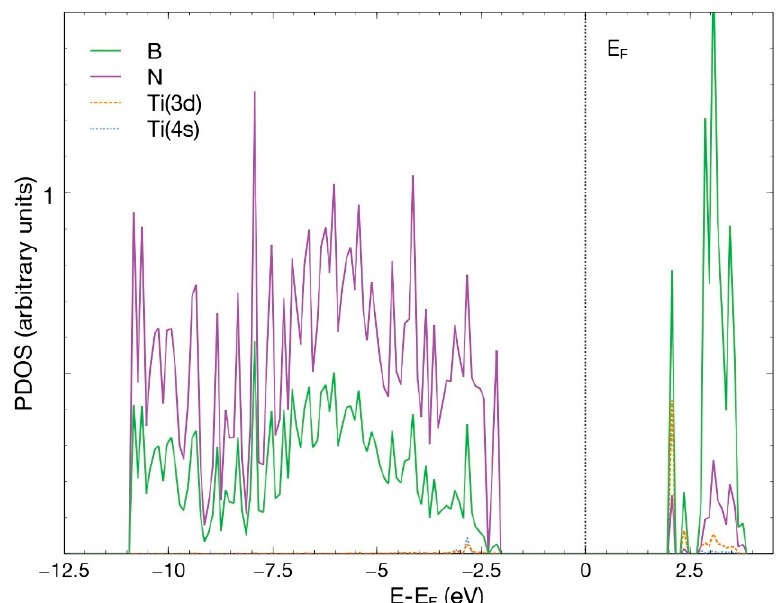
Figure 13. PDOS for the chemisorption of a Ti atom in an hBN surface with an N vacancy. We present p orbitals from B and N and the 3 d and 4 s orbitals from Ti.